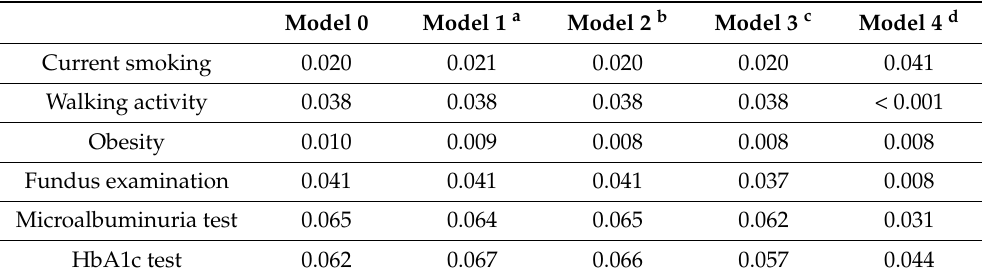
Table 4. Random effect analysis for individual- and district-level factors associated with taking diabetes complication screening tests and lifestyles in diabetes